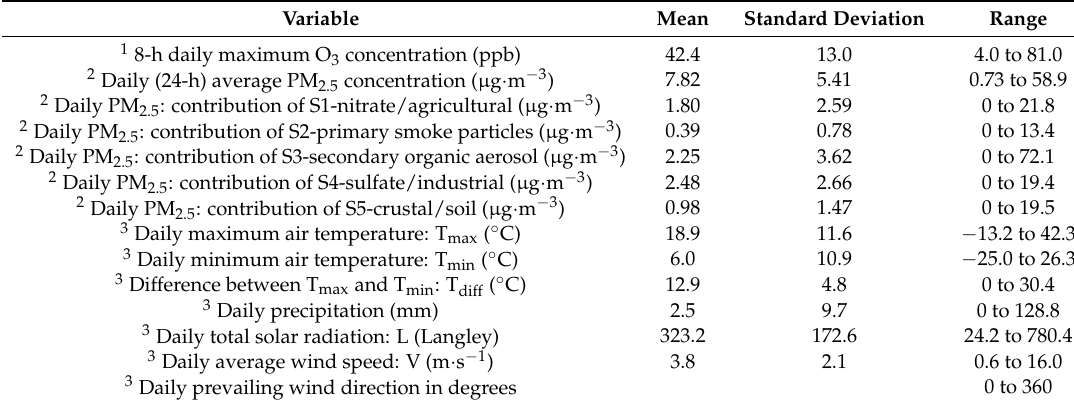
Table 1. Environmental and meteorological data used in regression analysis (2002 to